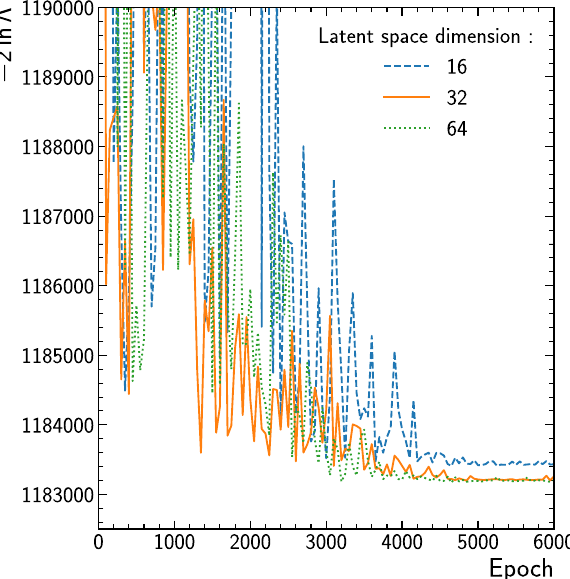
Fig. 3 Comparison of the − 2ln (cid:5) figure of merit evolution during the training of the different strategies tested for the addition of conditional features to the random latent ones